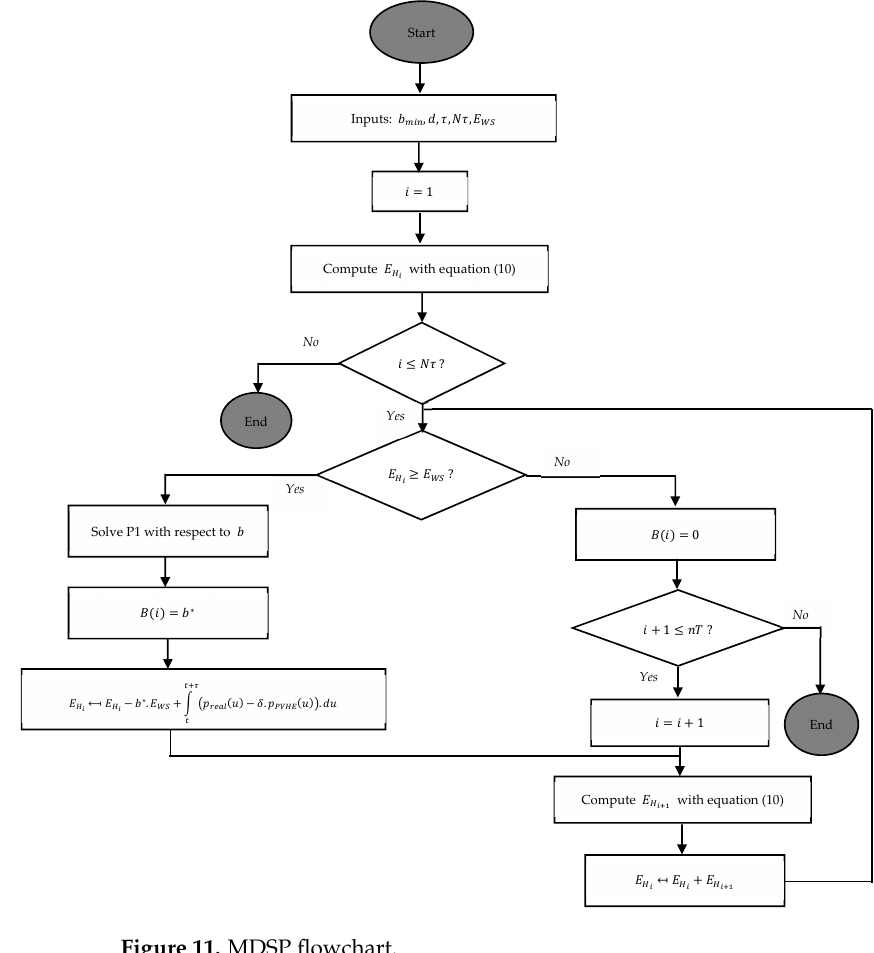
Figure 11. MDSP flowchart.